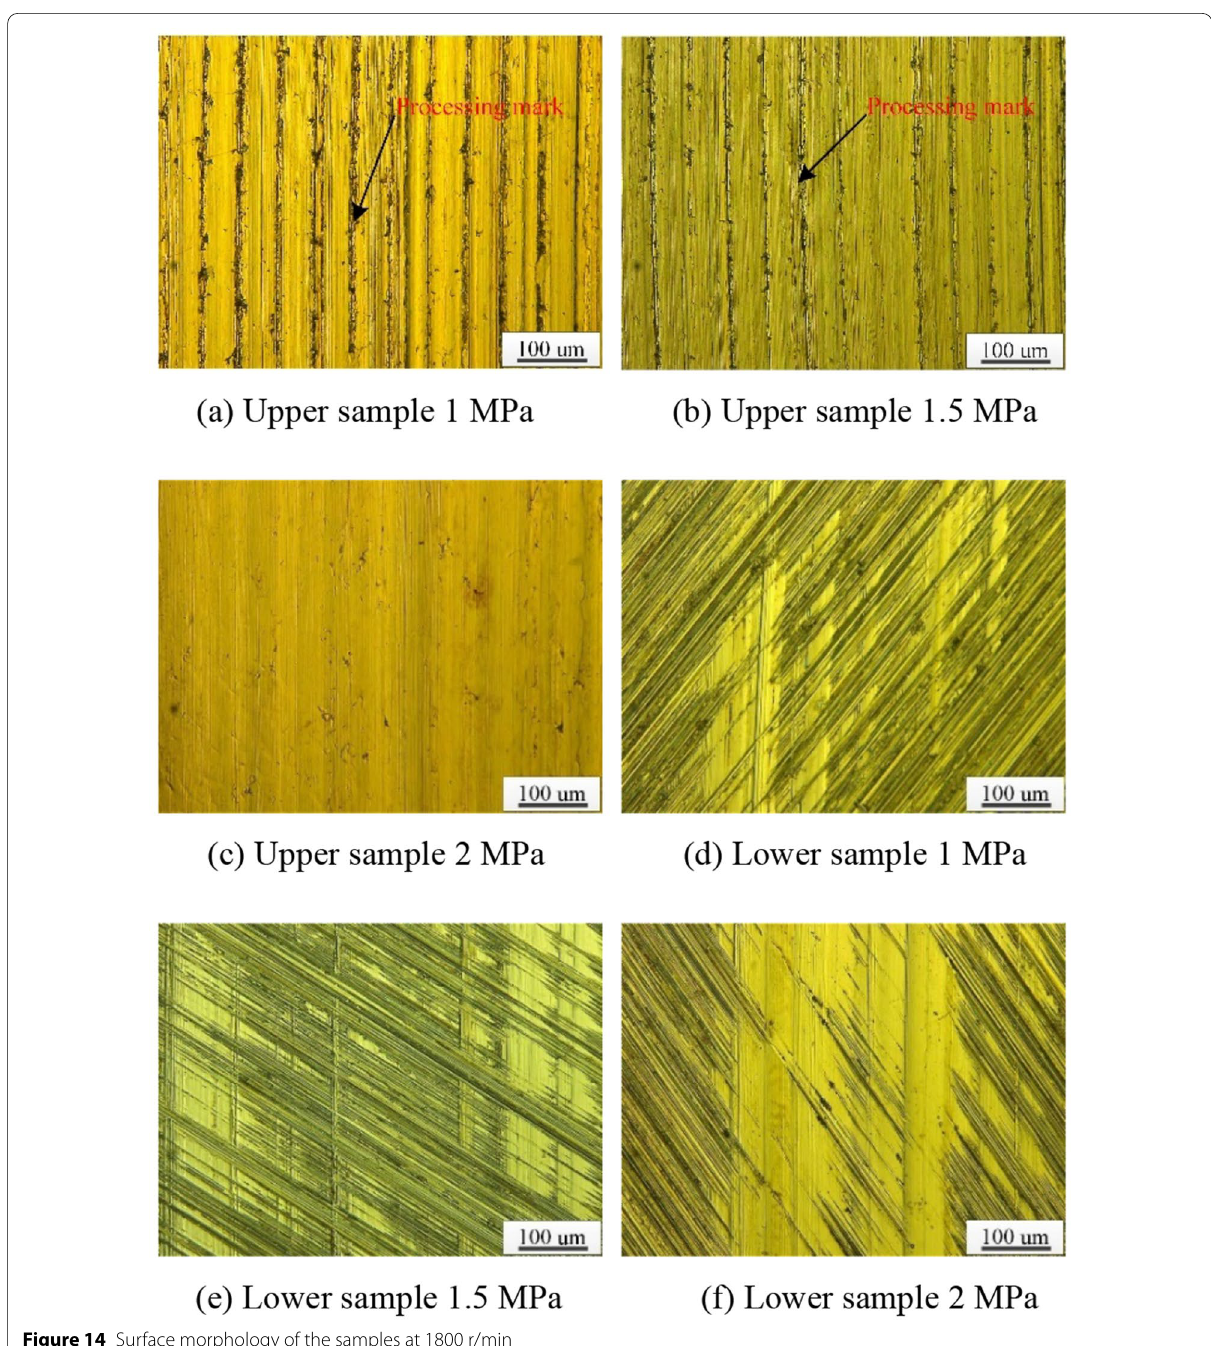
Figure 14 Surface morphology of the samples at 1800